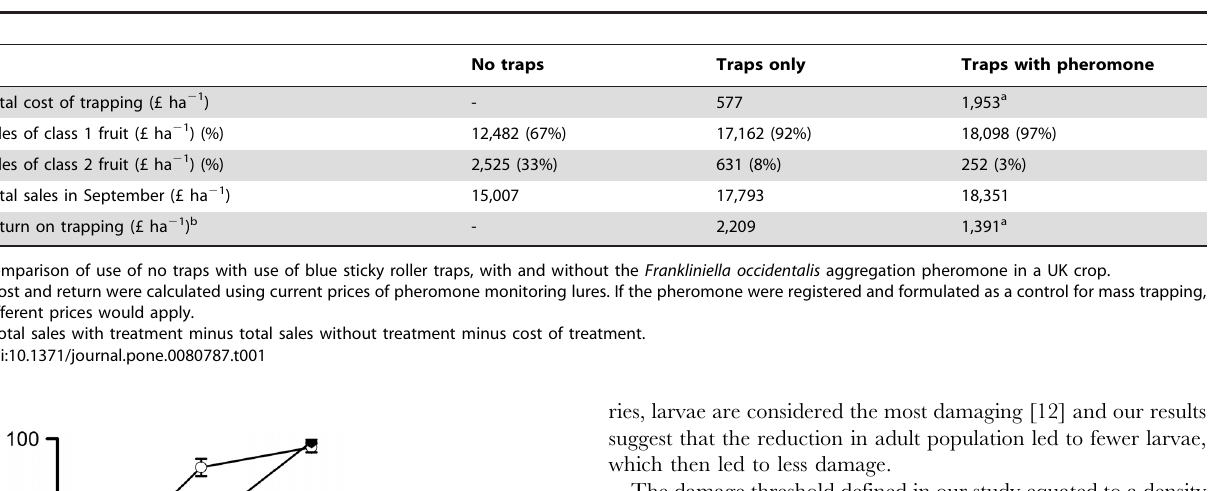
Table 1. Cost-benefit analysis of mass trapping in semi-protected strawberry.